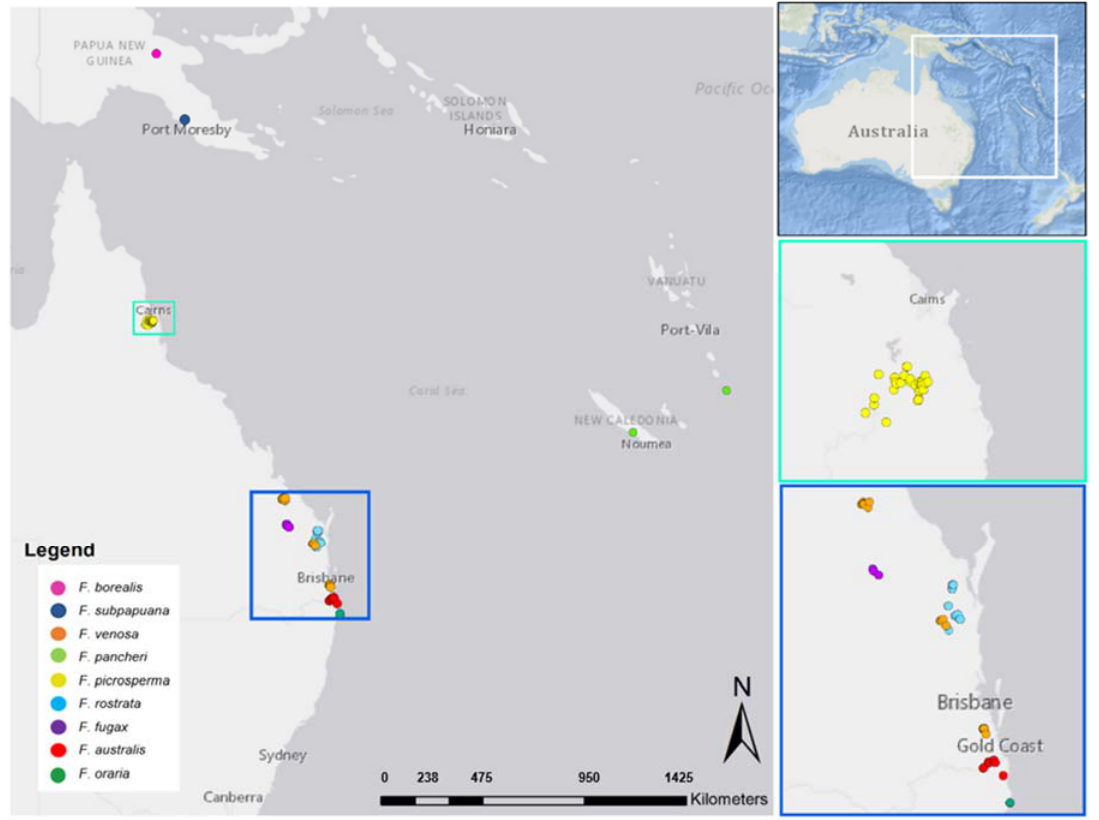
Figure 1. Geographic distribution of the Fontainea genus. Coloured boxes highlight the current known distribution of Australian Fontainea species. known distribution of Australian Fontainea